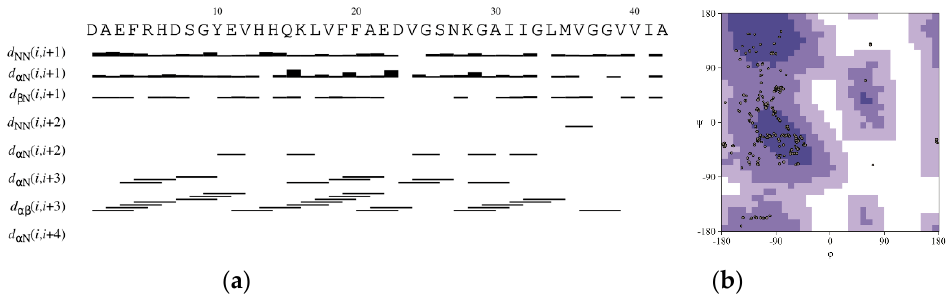
Figure 2. ( a ) Overview of the sequential and medium-range NOEs used to calculate the A β (1–42) peptide structure ensemble. ( b ) Ramachandran plot providing an overview of allowed and disallowed regions of torsion angle values.